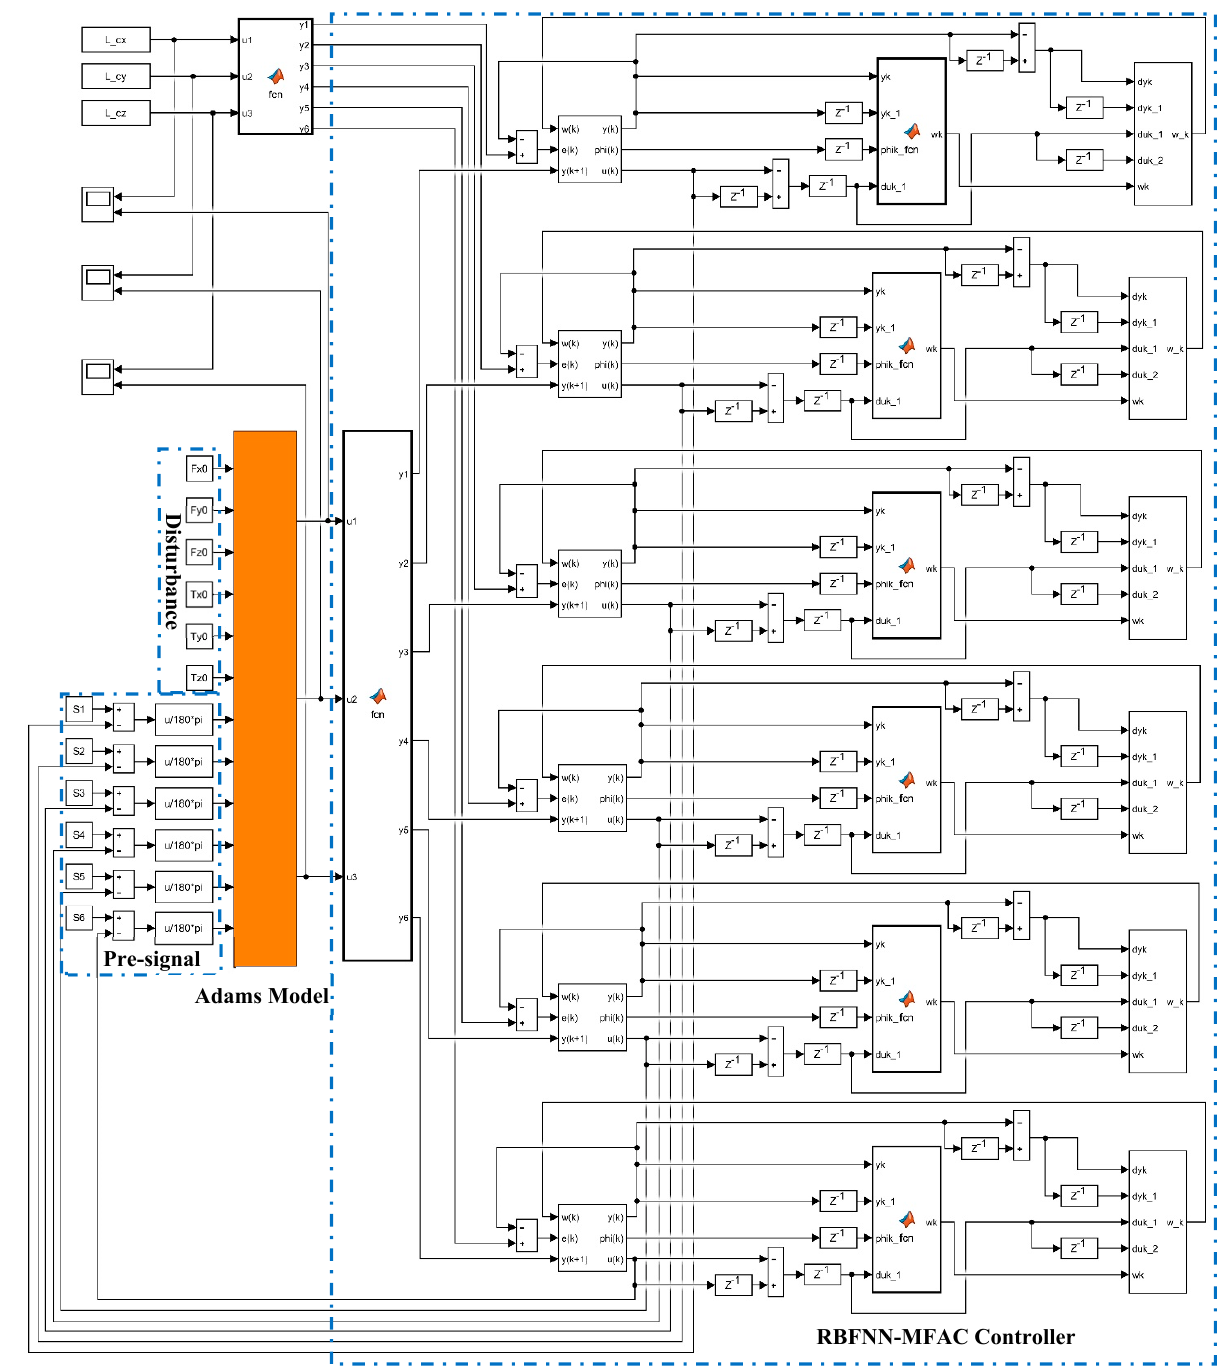
Figure 9. RBFNN-MFAC based on a Simulink Controller Model. The kernel of the RBFNN-MFAC controller is shown in Figure 10.